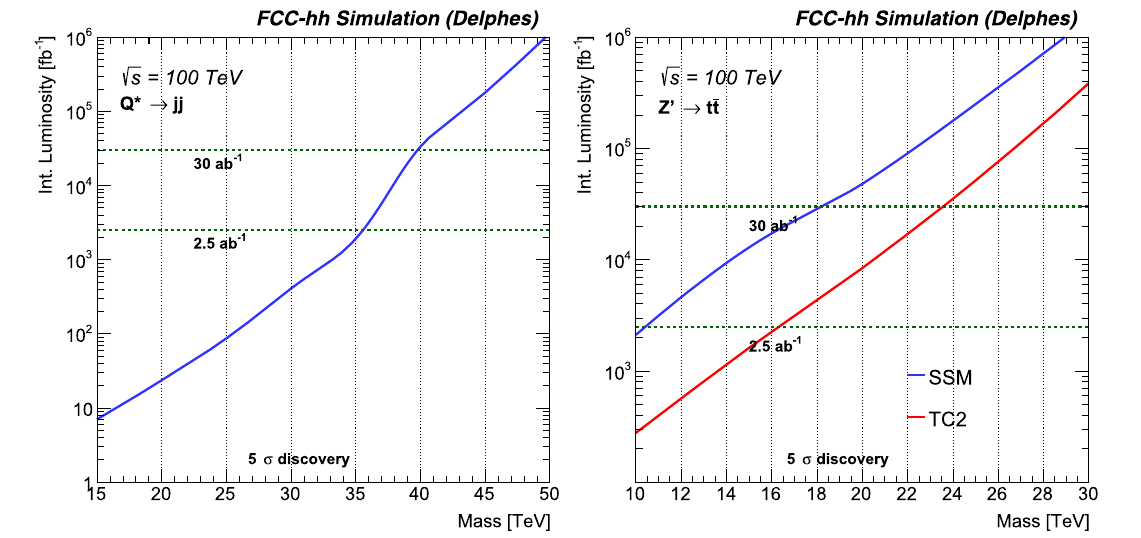
Fig. 8 5 σ discovery reach for the jj (left) and t ¯ t (right) final